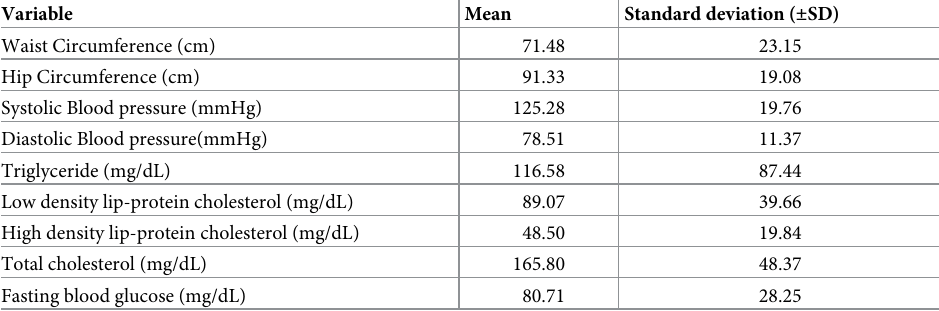
Table 2. The mean ( ± SD) Biochemical and anthropometric characteristics of the study population in a commu- nity-based survey among Gondar city residents who were � 18 years old, Northwest